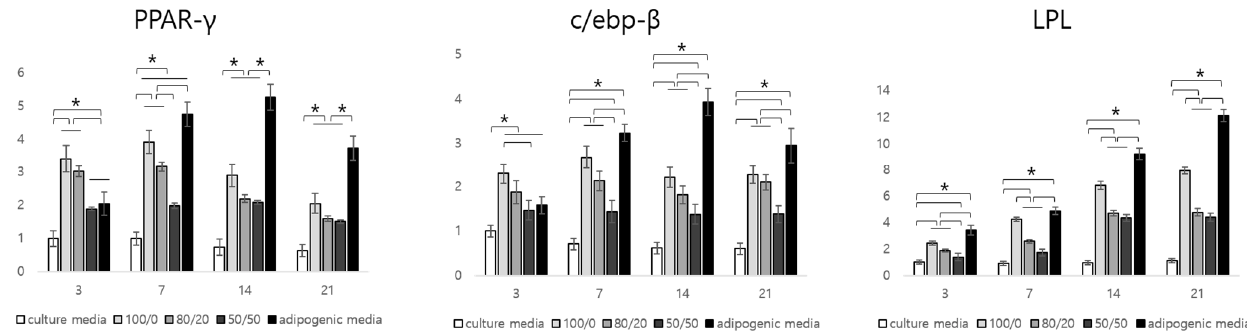
Figure 3. Relative gene expression of the mRNA of PPAR-, c/ebp-, and LPL of hADSCs/constructs culture in vitro for up to 21 days (* p < 0.05).